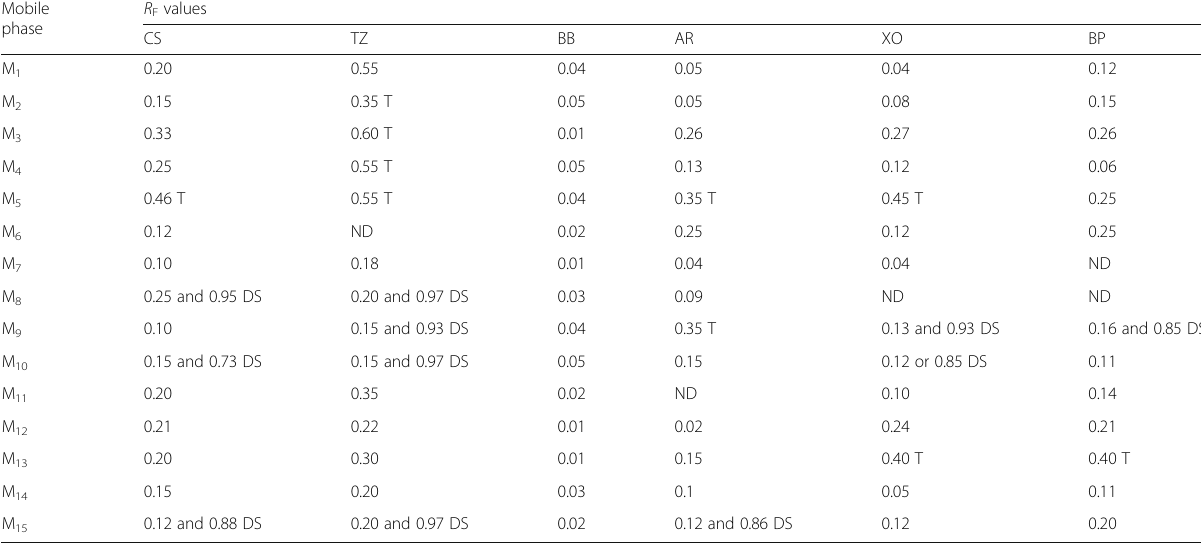
Table 3 Mobility of dyes in terms of R F values on stationary phase S 1 with different mobile phases Mobile phase